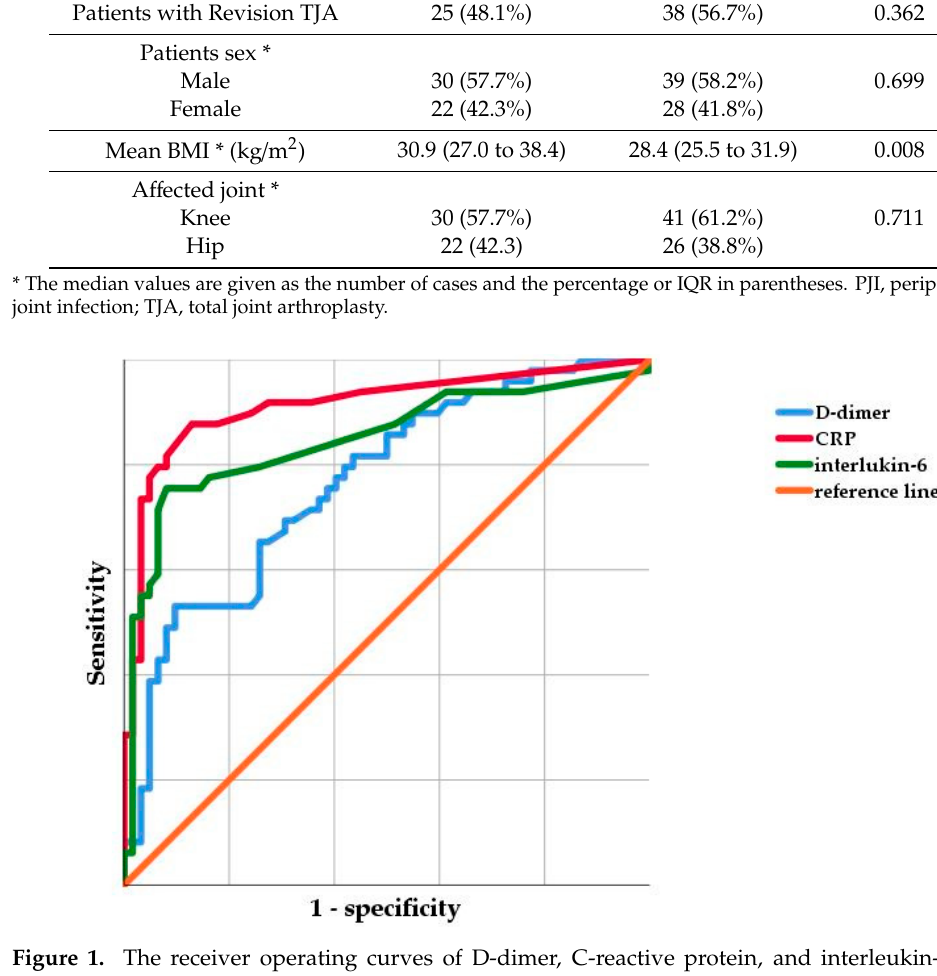
Figure 1. The receiver operating curves of D-dimer, C-reactive protein, and interleukin-6. CRP, C-reactive protein. The scale is in 0.2 increments from 0–1.